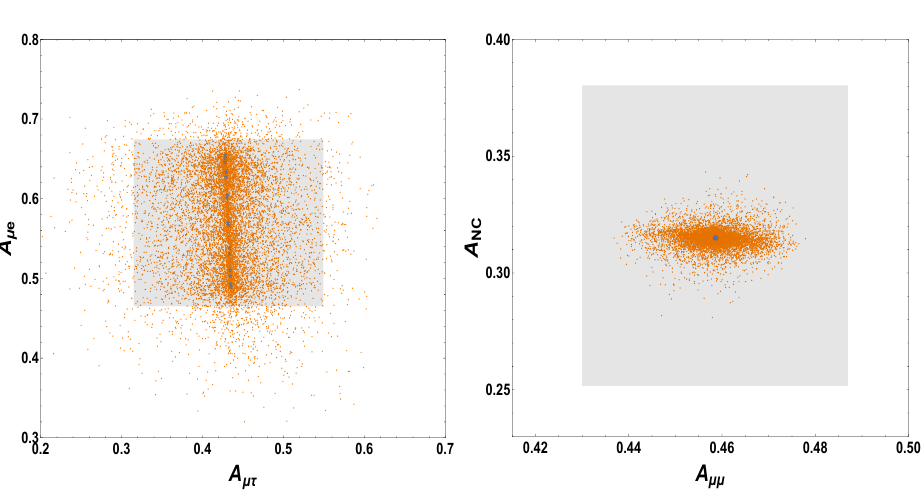
Figure 10. Same as Figure 9 but for the optimized